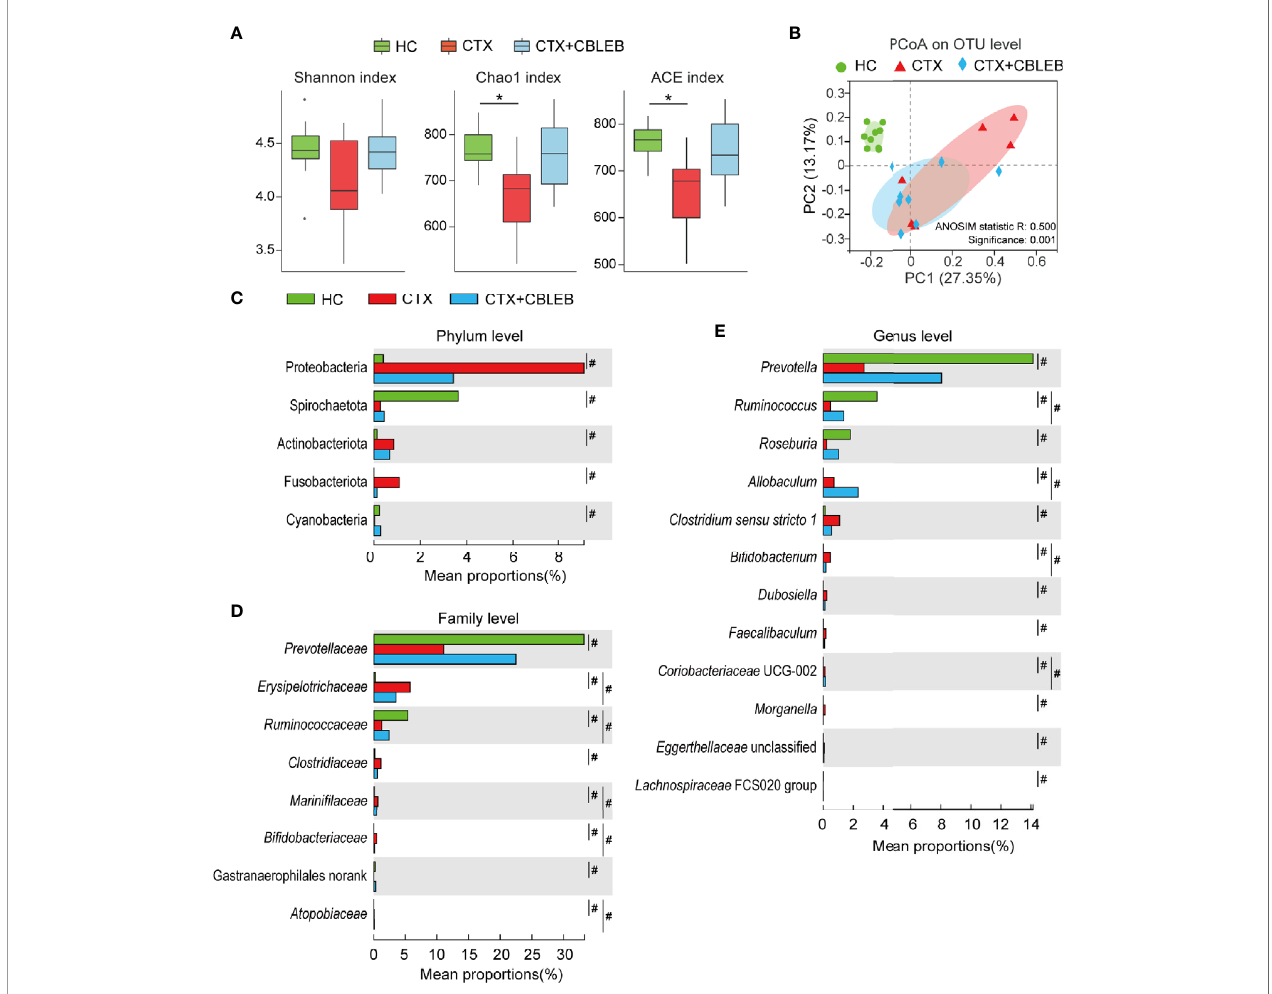
FIGURE 2 | CBLEB reverses cyclophosphamide-induced dysbiosis of the gut microbiota. (A) Box plot of species richness and fl ora diversity estimated based on the Chao1, ACE, and Shannon indexes. (B) Two-dimensional PCoA plot based on the Bray-Curtis matrix con fi rmed by ANOSIM. (C – E) Alterations in relative abundance of bacterial taxa in the CTX (n = 6), CTX+CBLEB (n = 8), and HC (n = 9) groups at the phylum (C) , family (D) , and genus (E) levels. * P < 0.05; # P adj <